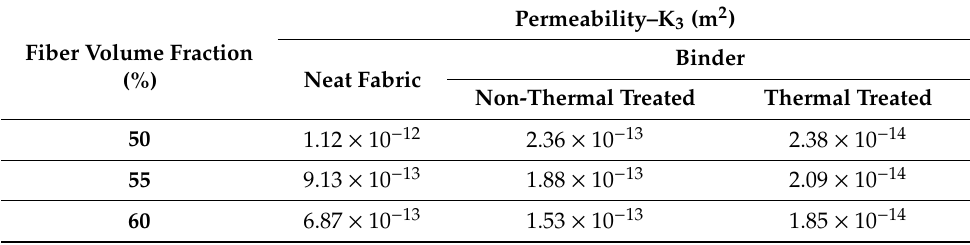
Figure 8. Change in the permeability in the out-of-plane direction according to the binder treatment. Table 3. Permeability of the fabric preform in the out-of-plane direction.